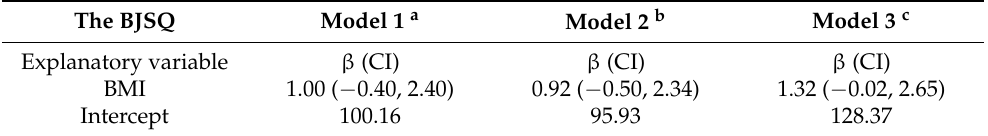
Table 3. Coefficients ( β ) and 95% confidence intervals for the association between BMI and the Brief Job Stress Questionnaire score ( n =